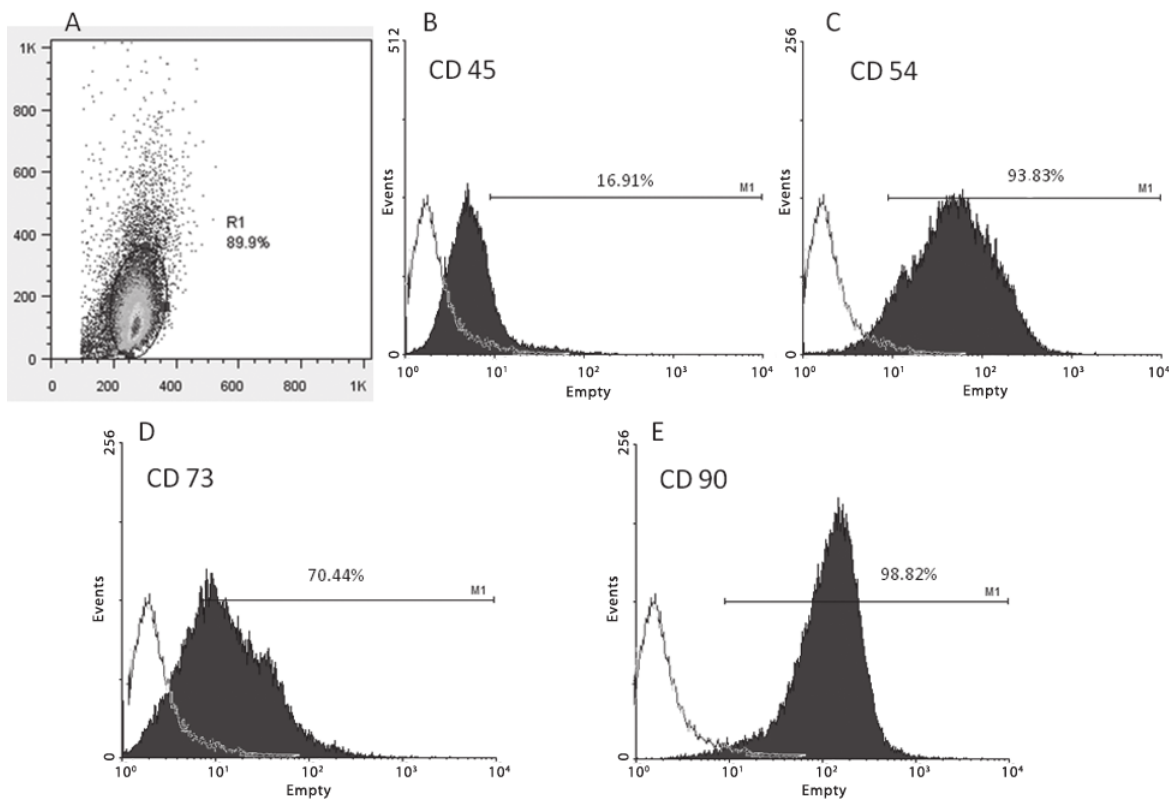
Figure 2 - Evaluation of the frequency of CD45, CD54, CD73 and CD90 by flow cytometry in mesenchymal stem cells derived from rats. The expression phenotype of CD54, CD73 and CD90 in 93.83%, 70.44% and 98.82% respectively, and no expression of CD45 in 83.09% of the cells